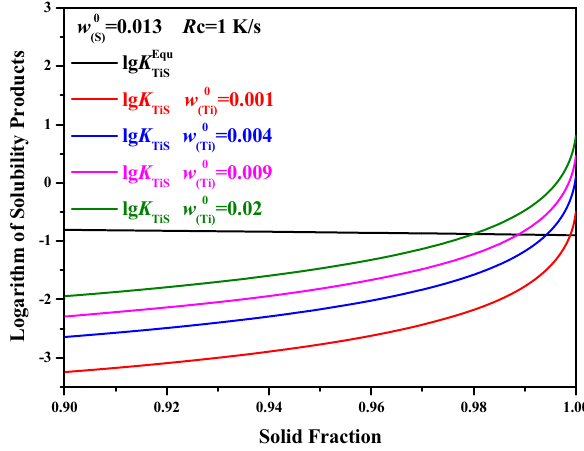
Figure 10: Relationship between the equilibrium solubility product and the actual values of Ti